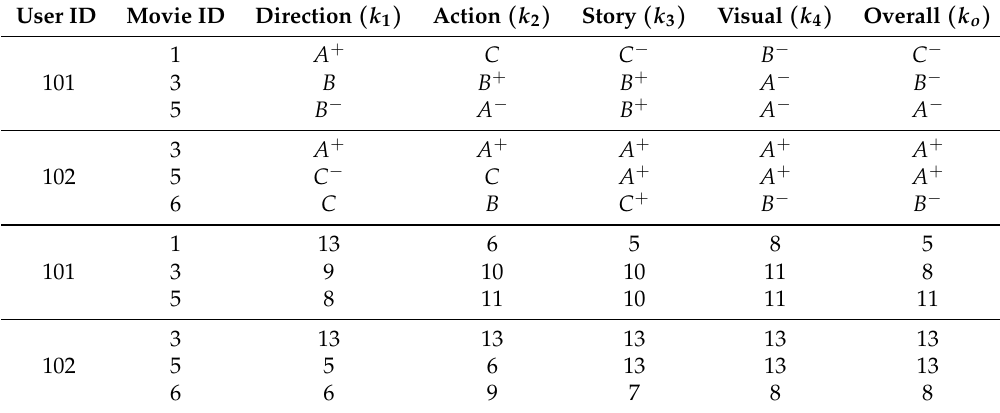
Table 1. Numerical representation of the sample